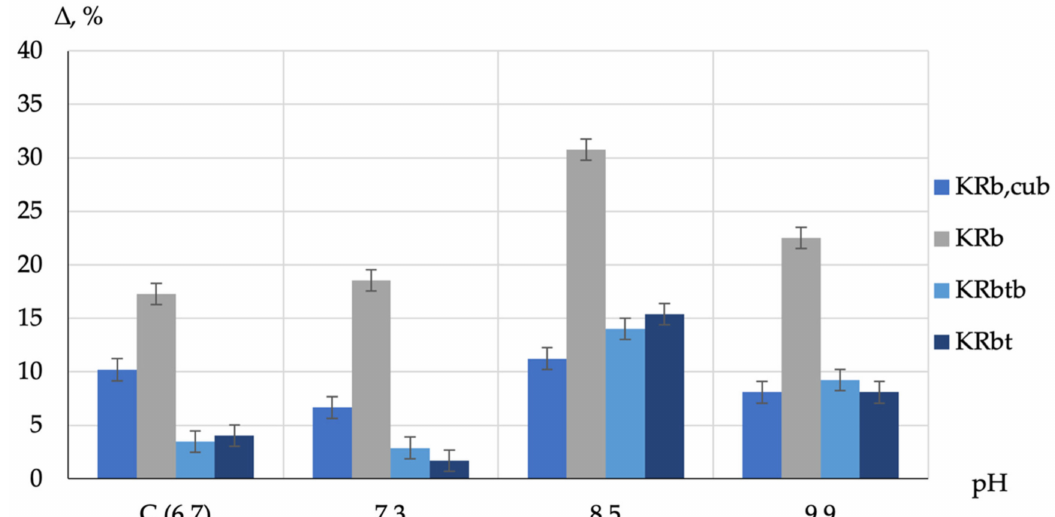
Figure 3. Dependence of the change in the coefficients of the strength variatropic efficiency of vibro-centrifuged concretes on the pH level of activated water (C is the control composition; ∆ is the value of the change in the coefficients of the strength variatropic efficiency).